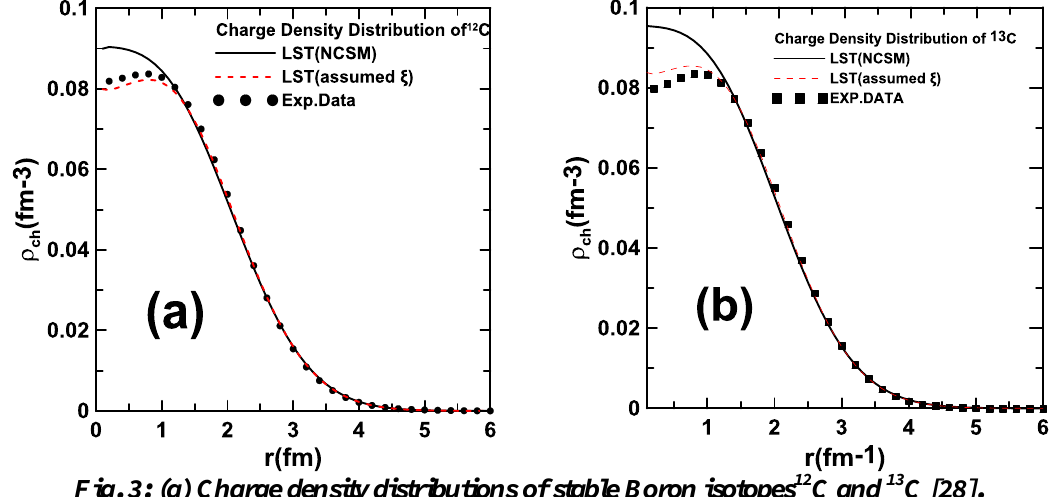
Fig. 3: (a) Charge density distributions of stable Boron isotopes 12 C and 13 C [28].